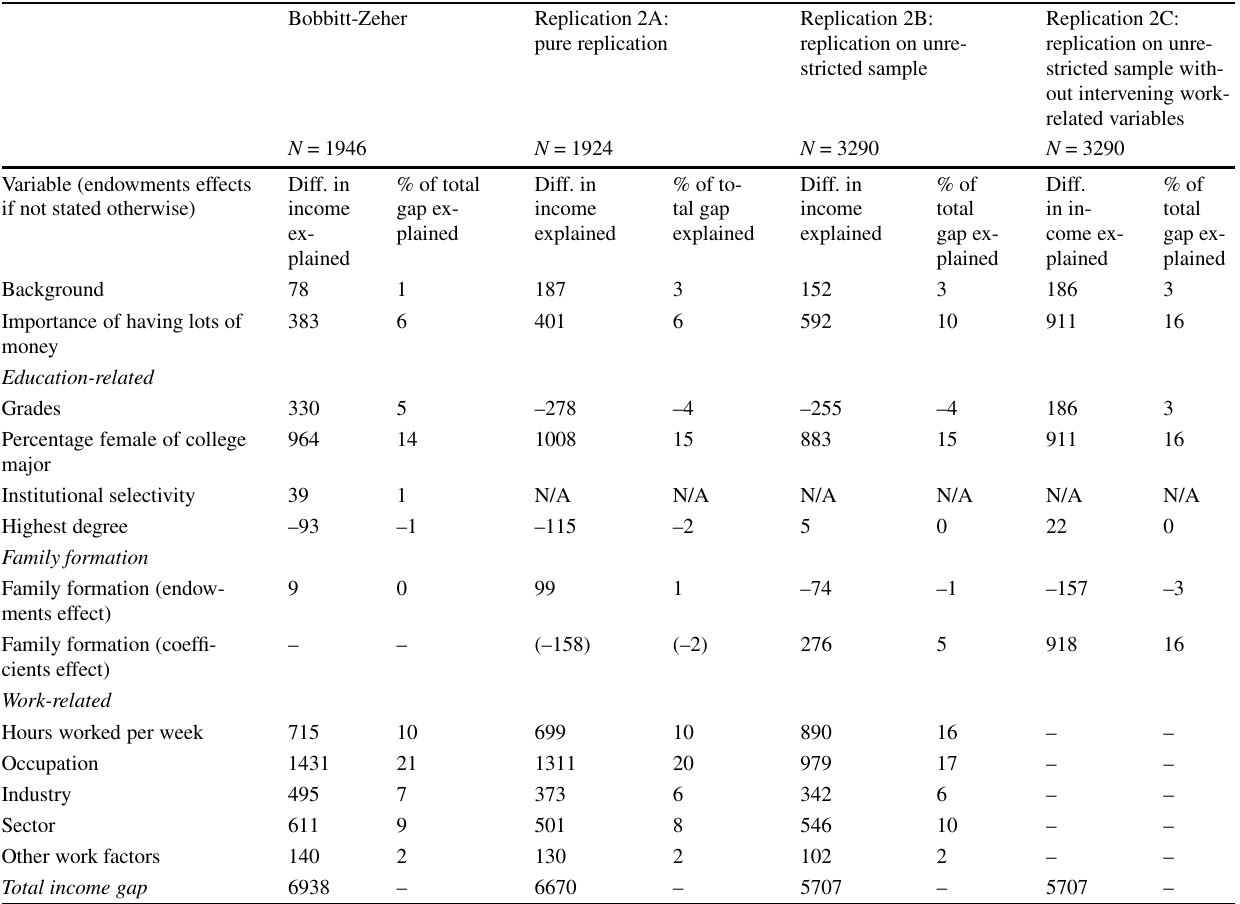
Table 2 Regression decompositions showing contributions of background, values, education, family formation, and work characteristics to the gender income